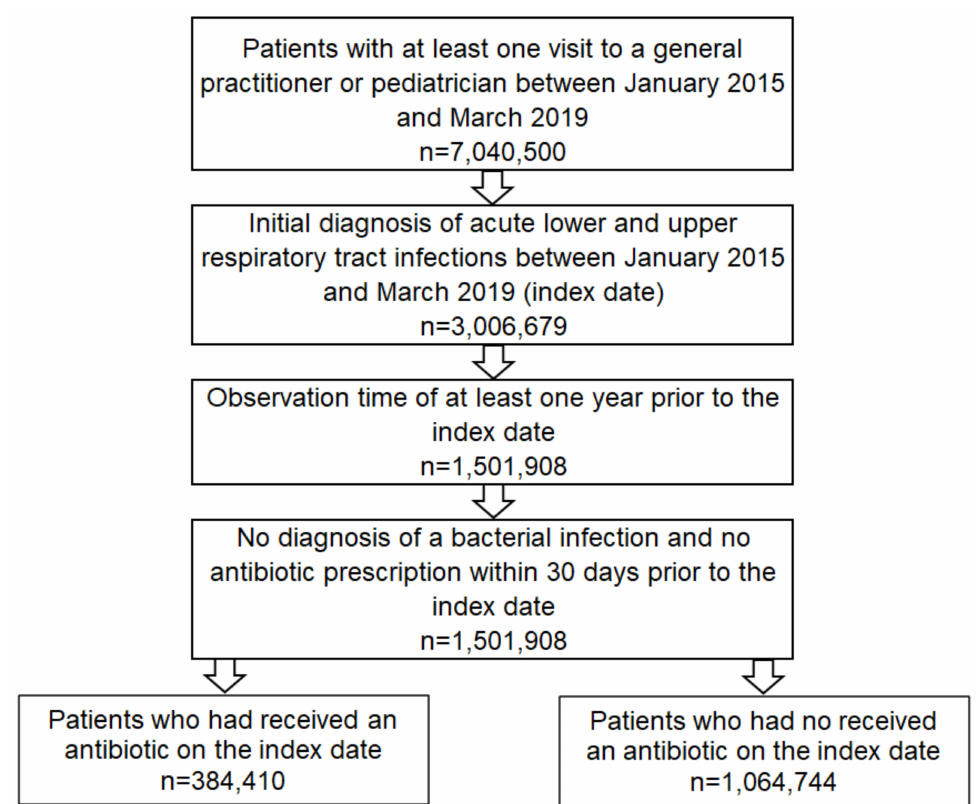
Figure 1. Selection of study patients from IMS Disease Analyzer